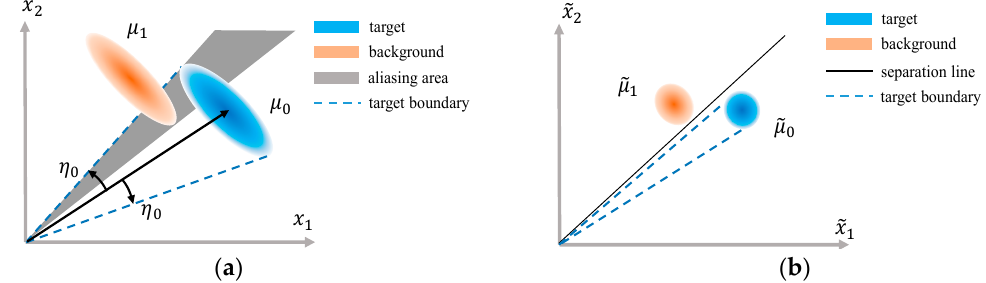
Figure 2. ( a ) The schematic diagram of the spectral angle mapper (SAM). ( b ) Illustration of the effect of the adaptive whitening process on data. µ 0 and µ 1 represent the target and the background in the original data space, respectively. (cid:101) µ 0 and (cid:101) µ 1 represent the target and the background in the whitened data space, respectively. There is aliasing in the original data space on the perspective of angle distance, and the aliasing phenomenon is alleviated in whitened data space.